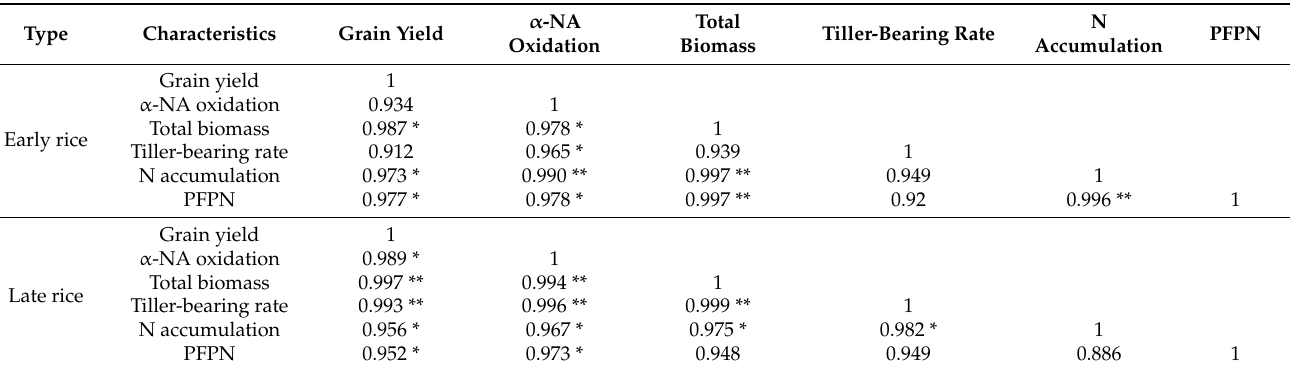
Table 4. Correlation coefficients of grain yield with main characteristics of the double cropping rice of different treatments (2018).